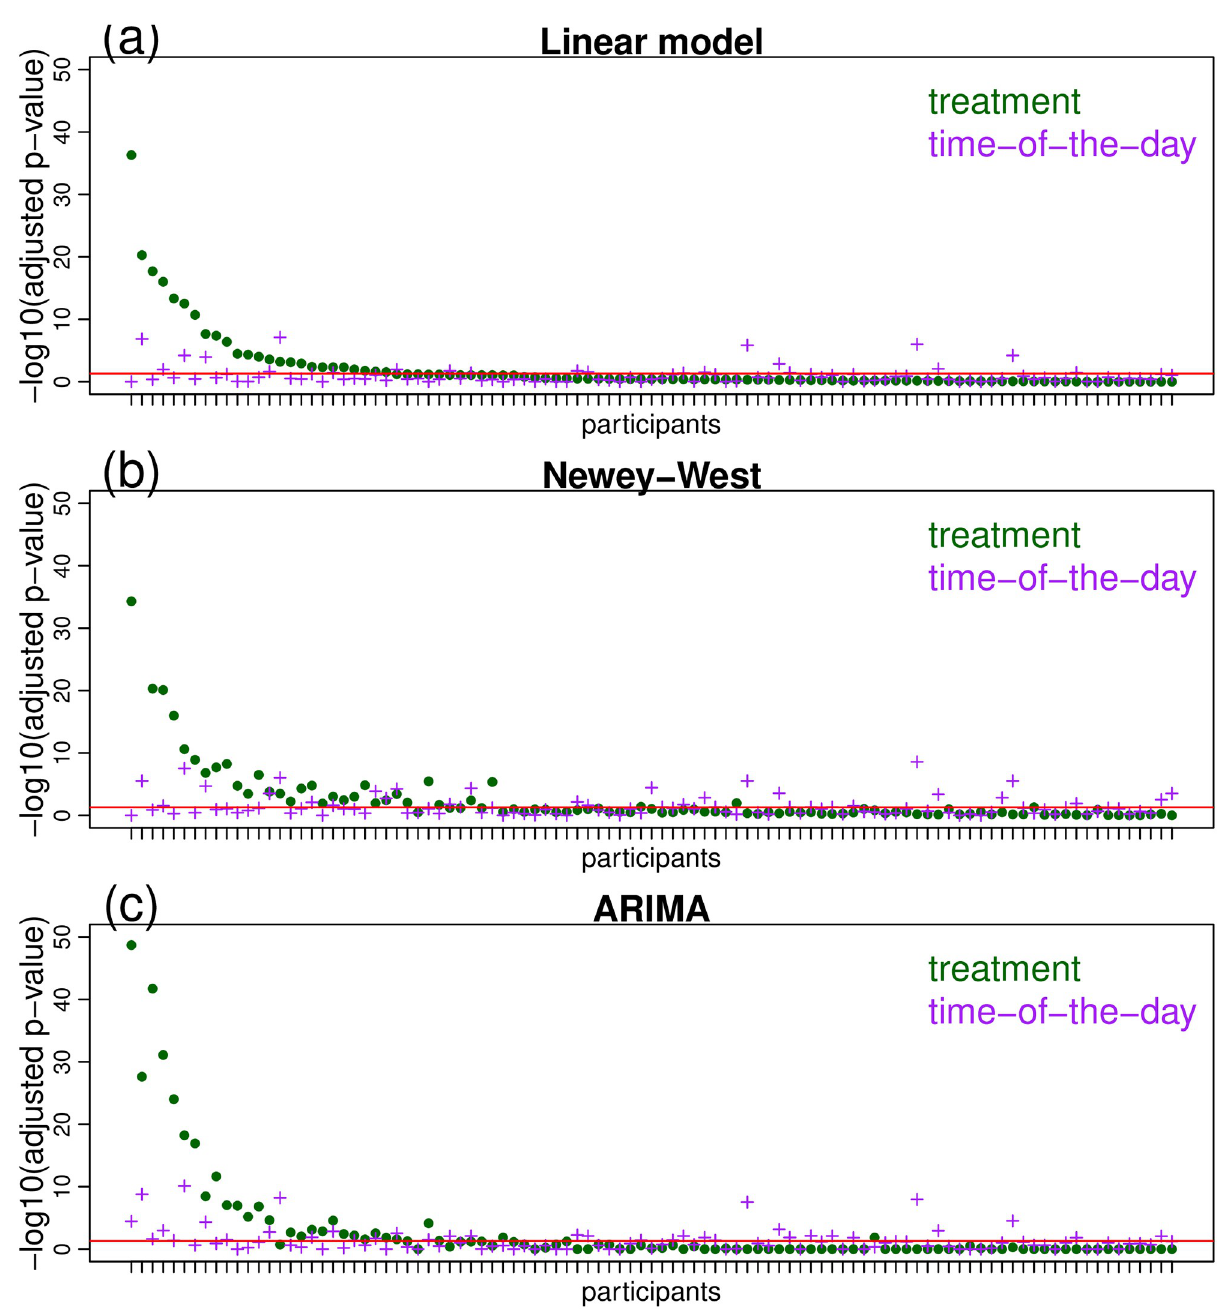
Fig 7. Personalized response to putative medication and time-of-the-day effects. Panels a, b and c show, respectively, the adjusted p-values (in -log 10 scale) from the union-intersection tests for putative medication effects (green dots) and putative time-of-the-day effects (purple plus signs), for the linear regression, Newey-West HAC covariance estimation, and ARIMA error models. The red horizontal lines correspond to a p-value threshold of 0.05. The order of the participants in the x-axis is the same for all panels, with the participants sorted according to the putative treatment p-value from the linear regression model (green dots) in panel